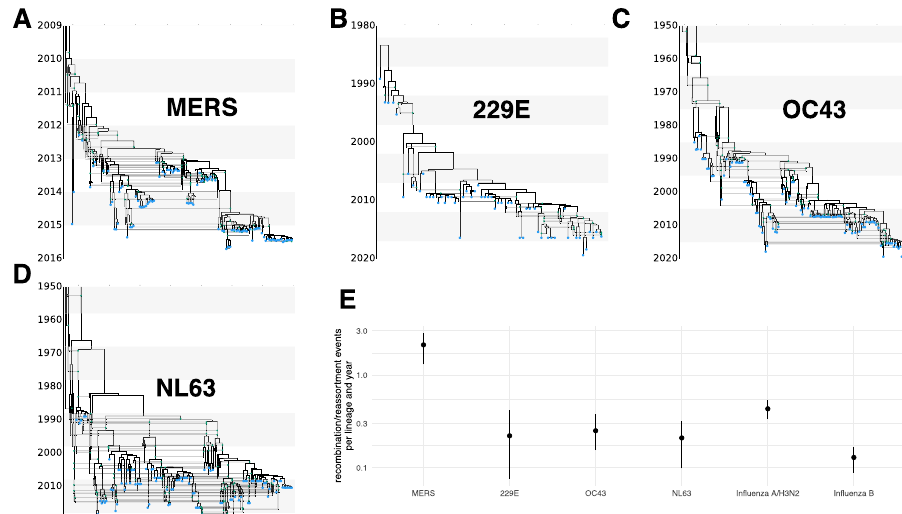
Fig. 2 Recombination networks and rates for coronaviruses MERS, 229E, OC43, and NL63. Recombination networks for MERS ( A ) and seasonal human coronaviruses 229E ( B ), OC43 ( C ), and NL63 ( D ). E Recombination rates (per lineage and year) for the different coronaviruses compared to reassortment rates in seasonal human in fl uenza A/H3N2 and in fl uenza B viruses as estimated in under the coalescent with reassortment using whole-genome in fl uenza sequences sampled over multiple decades 16 . For OC43 and NL63, the parts of the recombination networks that stretch beyond 1950 are not shown to increase the readability of more recent parts of the networks. The error bars denote the upper and lower bound of the 95% highest posterior density interval. All MCC networks are provided as a Source Data fi